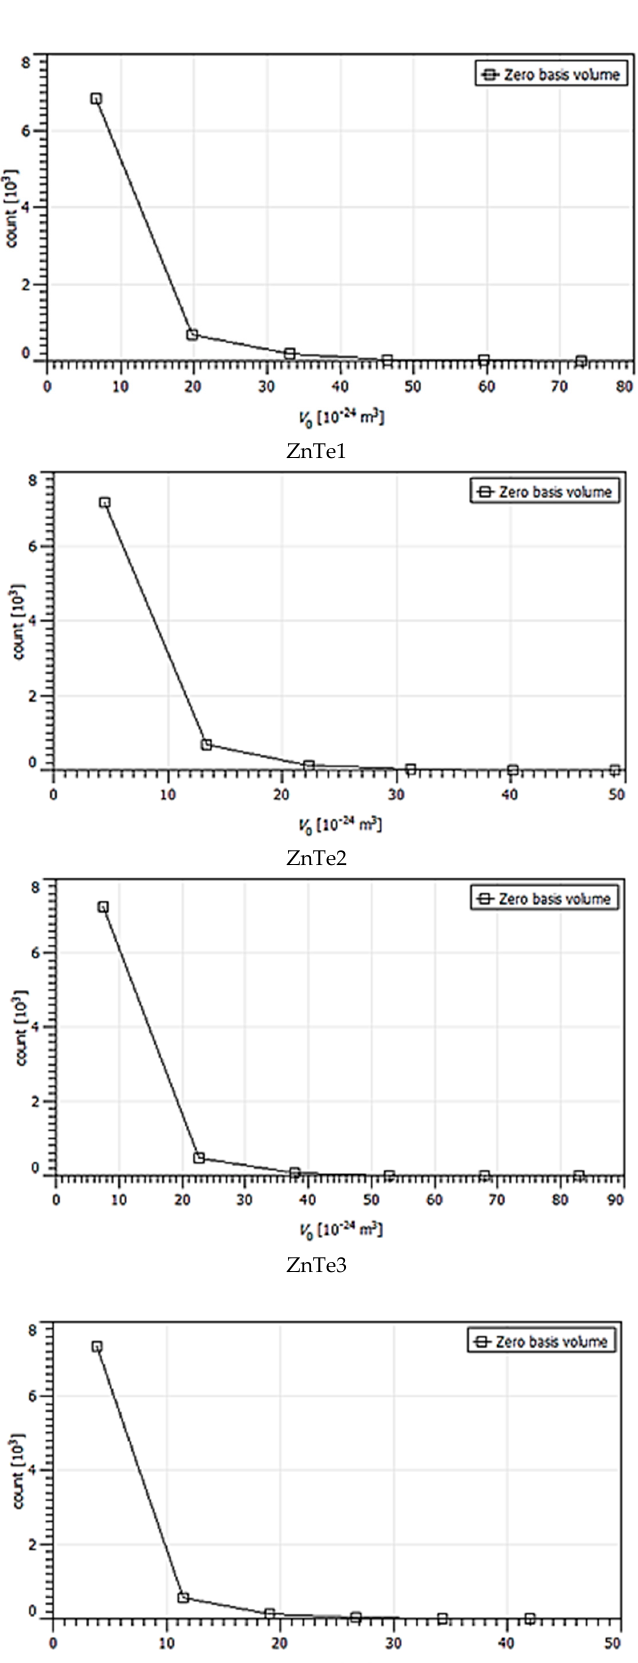
Figure 7. Projected boundary length statistic variation of ZnTe1,2,3,4 thin films.